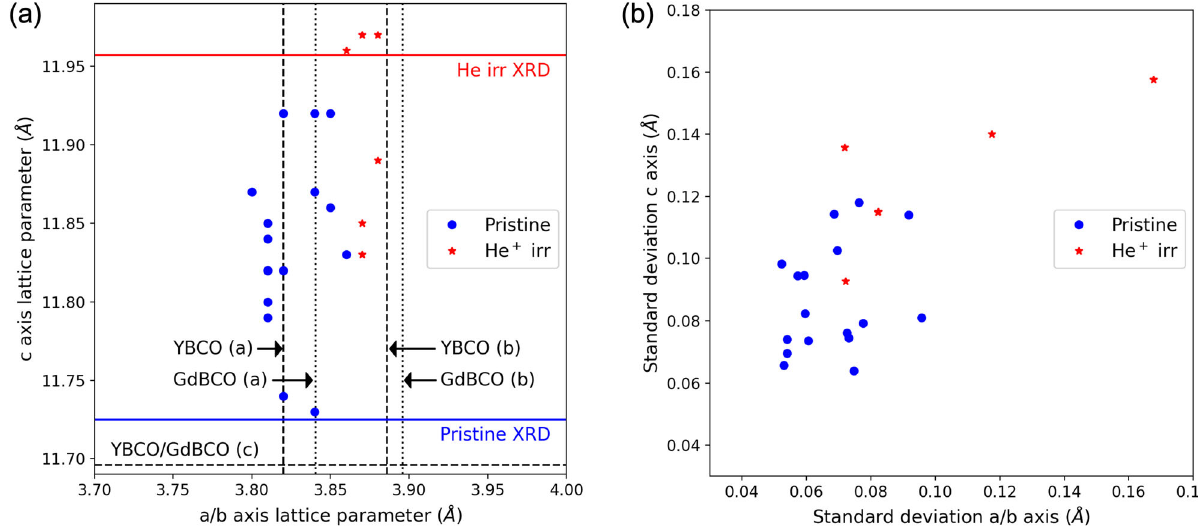
Fig. 3 Lattice parameter analysis of pristine and 10 16 He + irradiated samples. a Lattice parameter data extracted from aligned stacks of HAADF images such as those shown in Fig. 2. Each data point represents a different image stack, with the lattice parameter values averaged over about 300 unit cells. Reference lattice parameters for YBCO 83 and GdBCO 84 have been added as dashed lines. b Standard deviations in lattice parameter for each